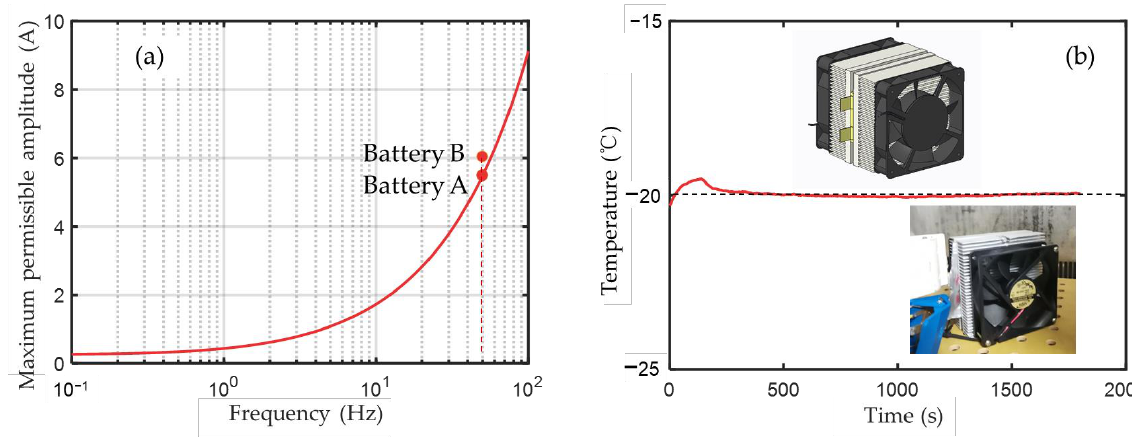
Figure 7. ( a ) The current parameters adopted in aging tests; ( b ) the battery temperature evolution during the repeated preheating, as well as the battery clamp.